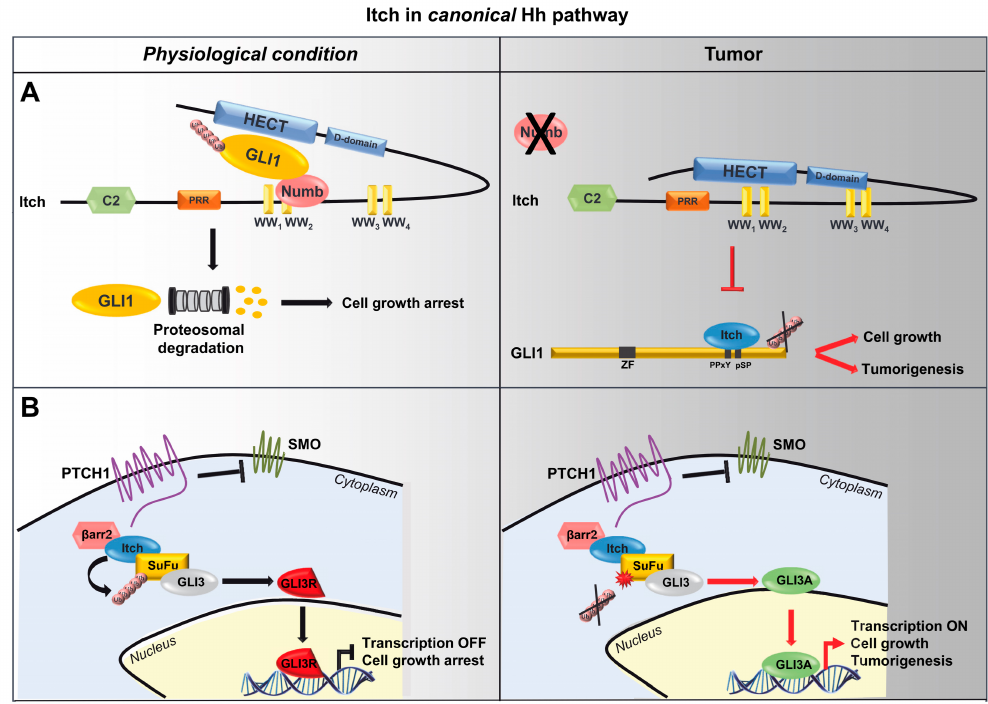
Figure 3. Role of Itch in canonical Hh pathway. ( A ) Model of the Numb/Itch-dependent regulation of GLI1 activity. Numb binds WW2 domain of Itch, releases Itch from its close-inactive conformation, thus allowing the recruitment of GLI1 and its degradation. In cancer, loss of Numb impairs this process enhancing GLI1 activity and promoting cell proliferation and tumorigenesis. ( B ) Model of the β -arrestin2/Itch-dependent regulation of the SuFu function. Itch, in complex with β -arrestin2, binds and ubiquitylates SuFu. This event does not lead to SuFu degradation but increases the association between SuFu and GLI3 promoting the generation of GLI3 repressor form (GLI3R) and inhibiting Hh signalling. Alterations in this mechanism, caused by SuFu mutations that make it insensitive to Itch-dependent ubiquitylation, are responsible for MB